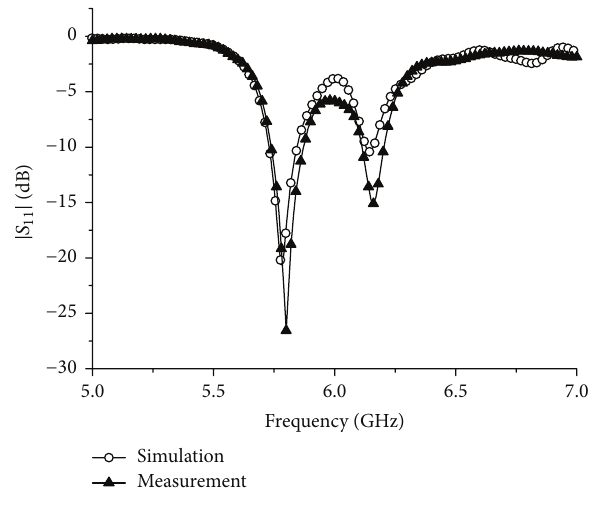
Figure 7: Measured and simulated |𝑆 11 |